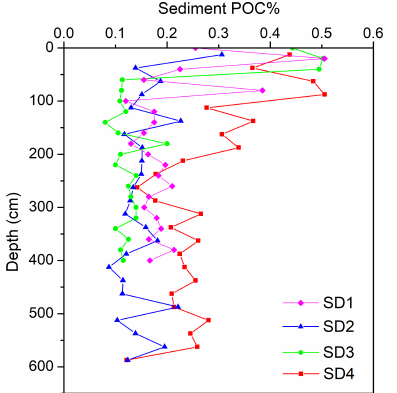
Figure 6. Variations of POC% with depth in buried sediments be- hind check dams (refer to Fig. 1 for their location).